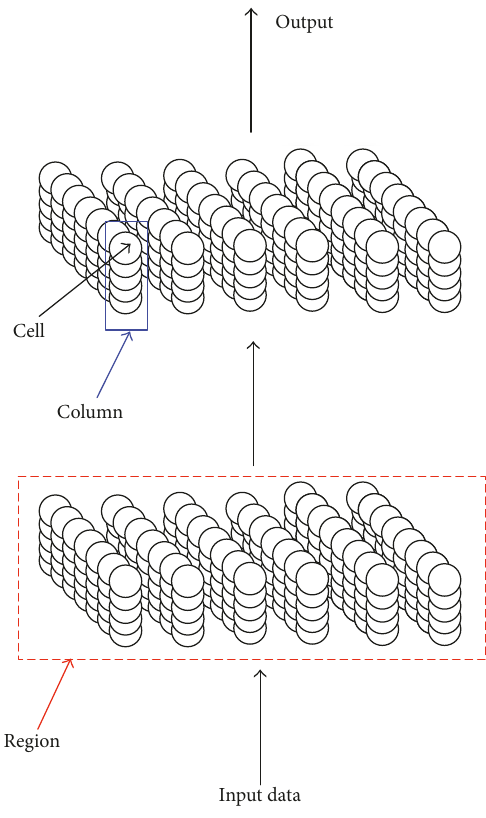
Figure 2: The structure of a typical HTM network.